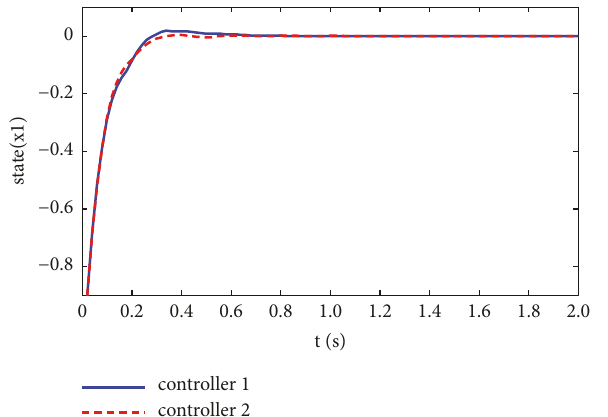
Figure 11: Trajectory of state 𝑥 1 with two controllers on condition 𝜏 = 4, 𝜌 = 4